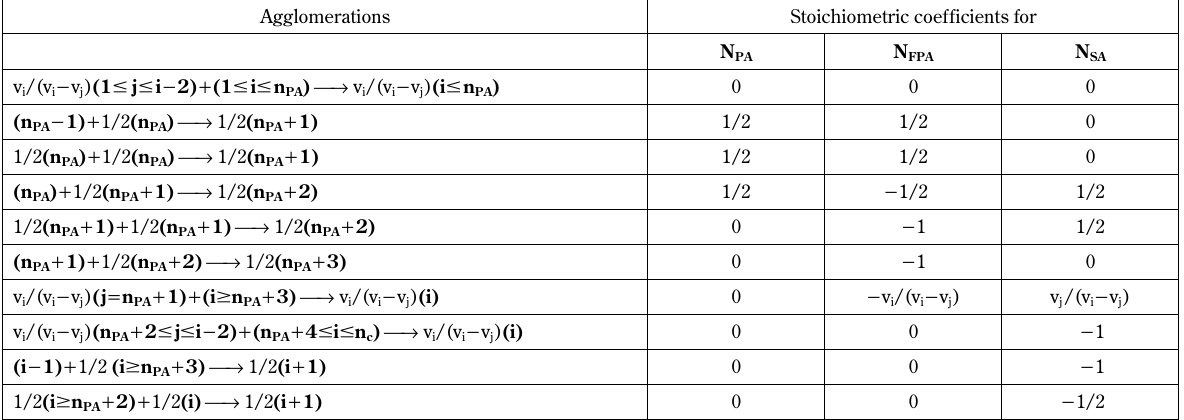
Table 4 Stoichiometric coefficients for primary agglomerates, free primary agglomerates, secondary agglomerates concentrations depending on the type of agglomeration: (i) represents the i th -class of particles. Free primary agglomerates are only encountered in class n PA (cid:3) 1. The standard virtual agglomerate of class n (cid:5) n PA (cid:3) 1 encompasses 2n (cid:4) n PA (cid:4) 1 primary